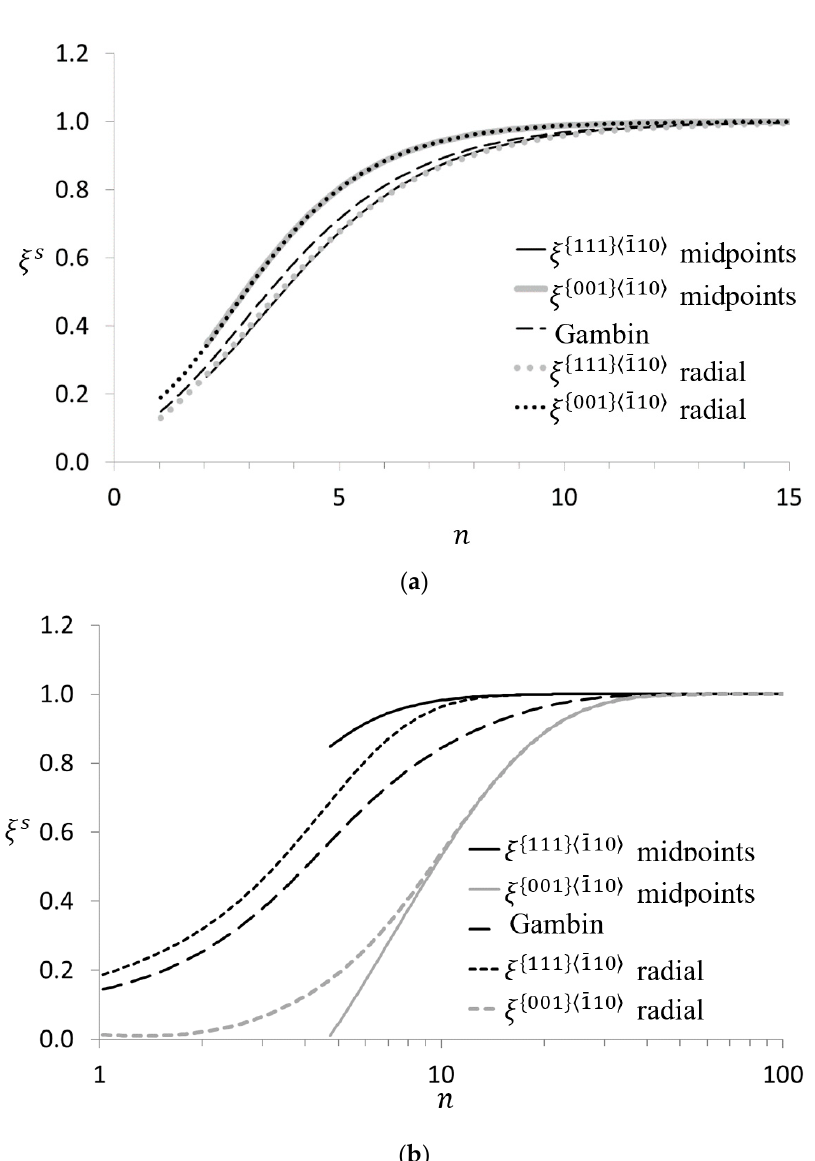
Figure 3. The fitted coefficients of the yield surface as functions of the exponent 𝑛 , for the case of fcc with ( a ) octahedral (cid:4668)111(cid:4669)⟨1(cid:4636)10⟩ and ( b ) additional nonoctahedral (cid:4668)001(cid:4669)⟨1(cid:4636)10⟩ slip systems, fitted to the facet midpoints, by the regularization proposed by Gambin, and fitted radially to the facets. ( a ) 𝜏 (cid:3030)(cid:4668)(cid:2868)(cid:2868)(cid:2869)(cid:4669)⟨(cid:2869)(cid:4636)(cid:2869)(cid:2868)⟩ = 𝜏 (cid:3030)(cid:4668)(cid:2869)(cid:2869)(cid:2869)(cid:4669)⟨(cid:2869)(cid:4636)(cid:2869)(cid:2868)⟩ and ( b ) 𝜏 (cid:3030)(cid:4668)(cid:2868)(cid:2868)(cid:2869)(cid:4669)⟨(cid:2869)(cid:4636)(cid:2869)(cid:2868)⟩ = 1.5𝜏 (cid:3030)(cid:4668)(cid:2869)(cid:2869)(cid:2869)(cid:4669)⟨(cid:2869)(cid:4636)(cid:2869)(cid:2868)⟩ .